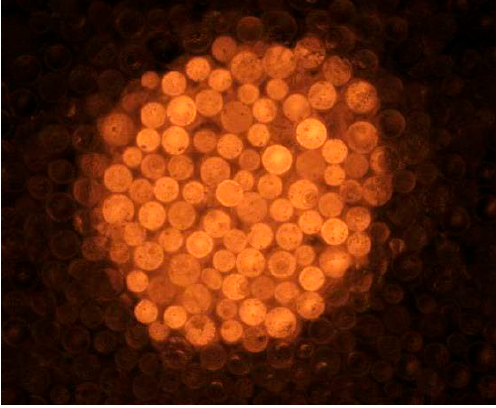
Figure 4. RPL emission image of bead-type Ag + -doped phosphate glass.